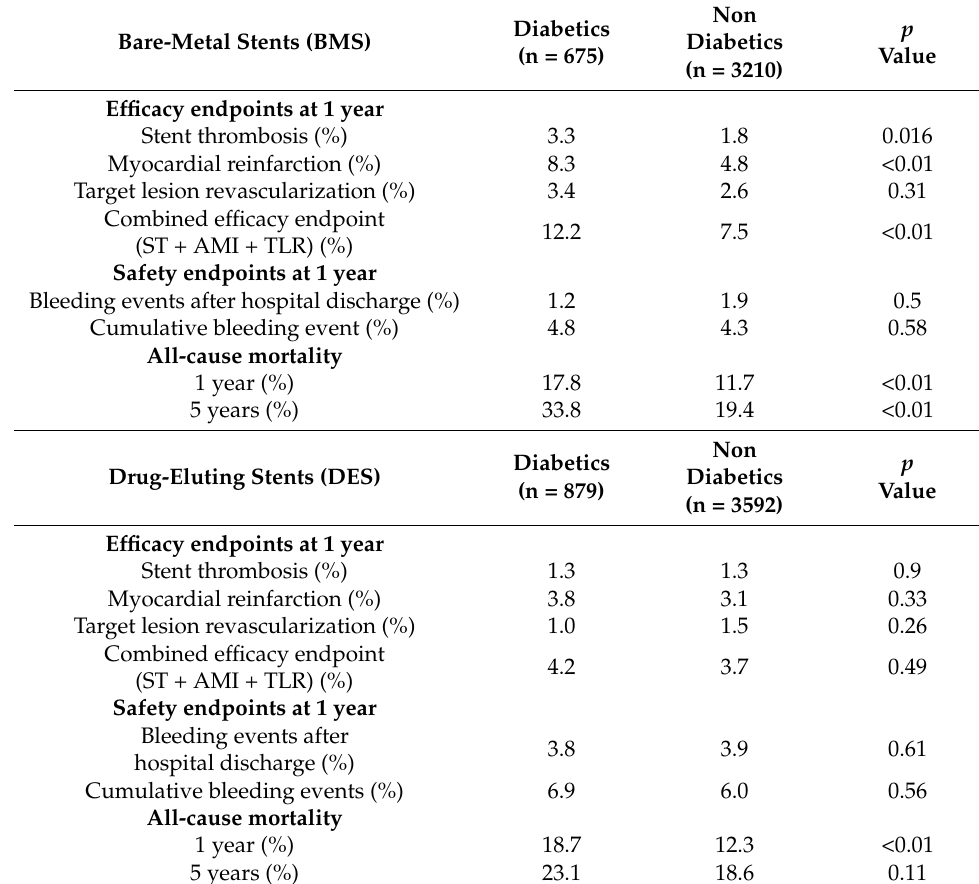
Table 4. Events rates in diabetics vs. non-diabetics stratified by stent-type.